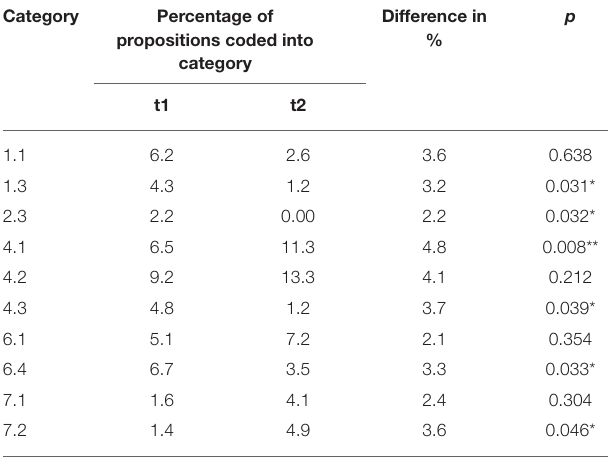
TABLE 3B | Teacher trainees in mono-professional teams at t1 compared to t2: relative frequency of propositions coded into the respective categories. Difference in Category Percentage of Category Percentage of % propositions coded into propositions coded category